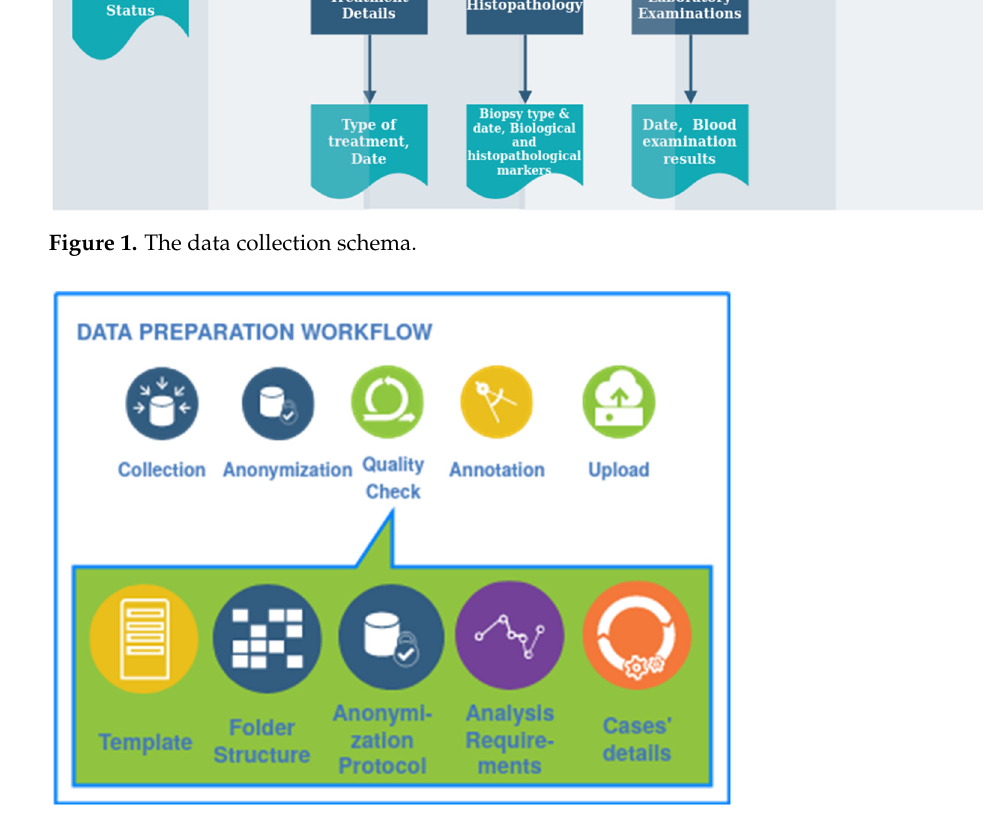
Figure 1. The data collection schema.